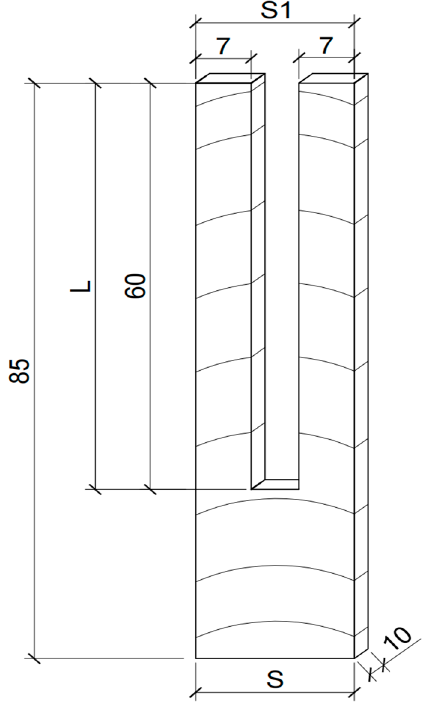
Figure 1. The prong samples for residual stress measurement (Unit: mm).